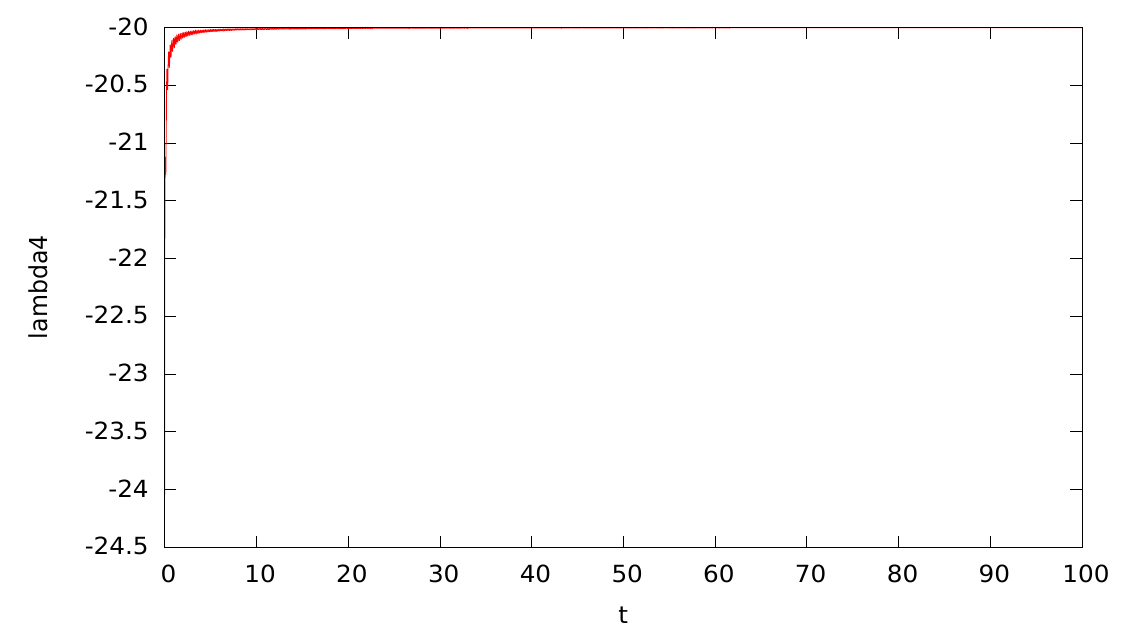
Figure 6. The graph of the change in time of the Lyapunov exponent LE 4